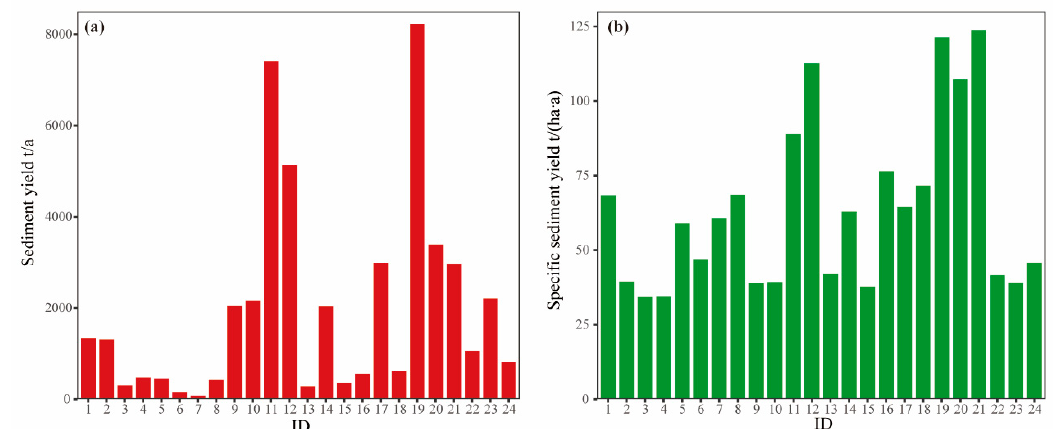
Figure 4. Sediment yield estimation from field survey. ( a ) Sediment yield, ( b ) specific sediment